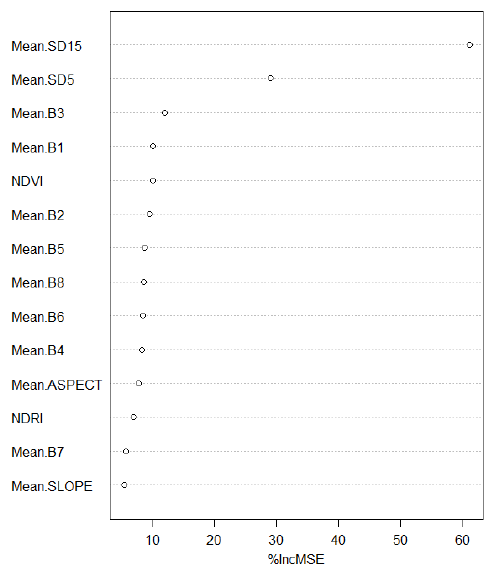
Figure 6. Contribution of individual variables to the Vegetation Cover Fraction (VCF)